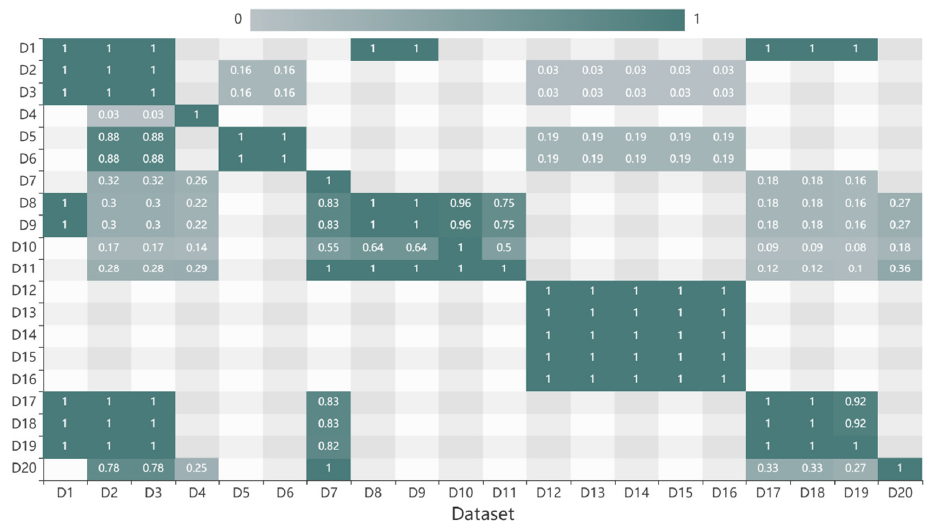
Figure 7. Temporal similarities of datasets.